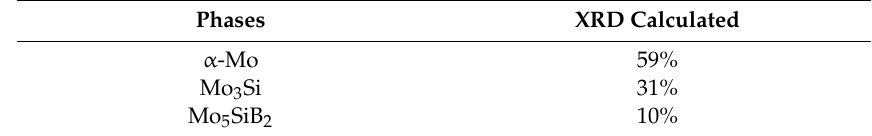
Table 1. Phase fraction, calculated from the XRD analysis.